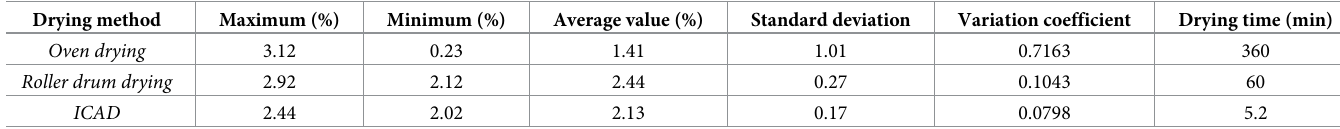
Table 2. The final moisture content of Poplar fiber by different drying